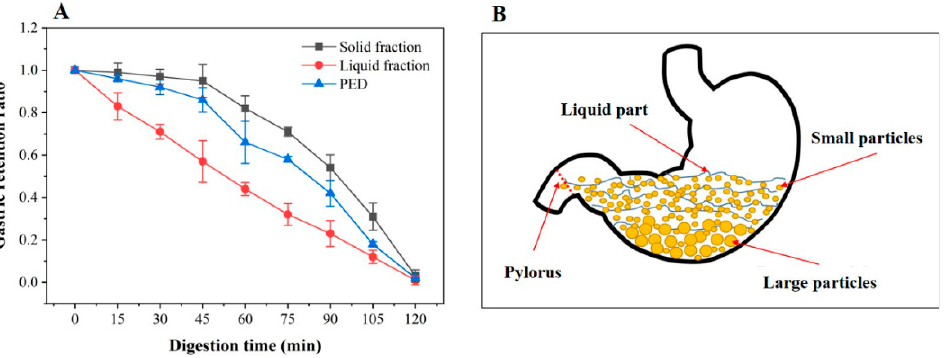
Figure 1. Changes in pH ( A , B ), protein ( C ) and fat ( D ) digestibility of preserved eggs during the digestion. A , B represent the pH of the stomach and intestine; C , D represent protein and fat digestibility during intestinal digestion. Different lowercase letters indicate significant differences ( p < 0.05).